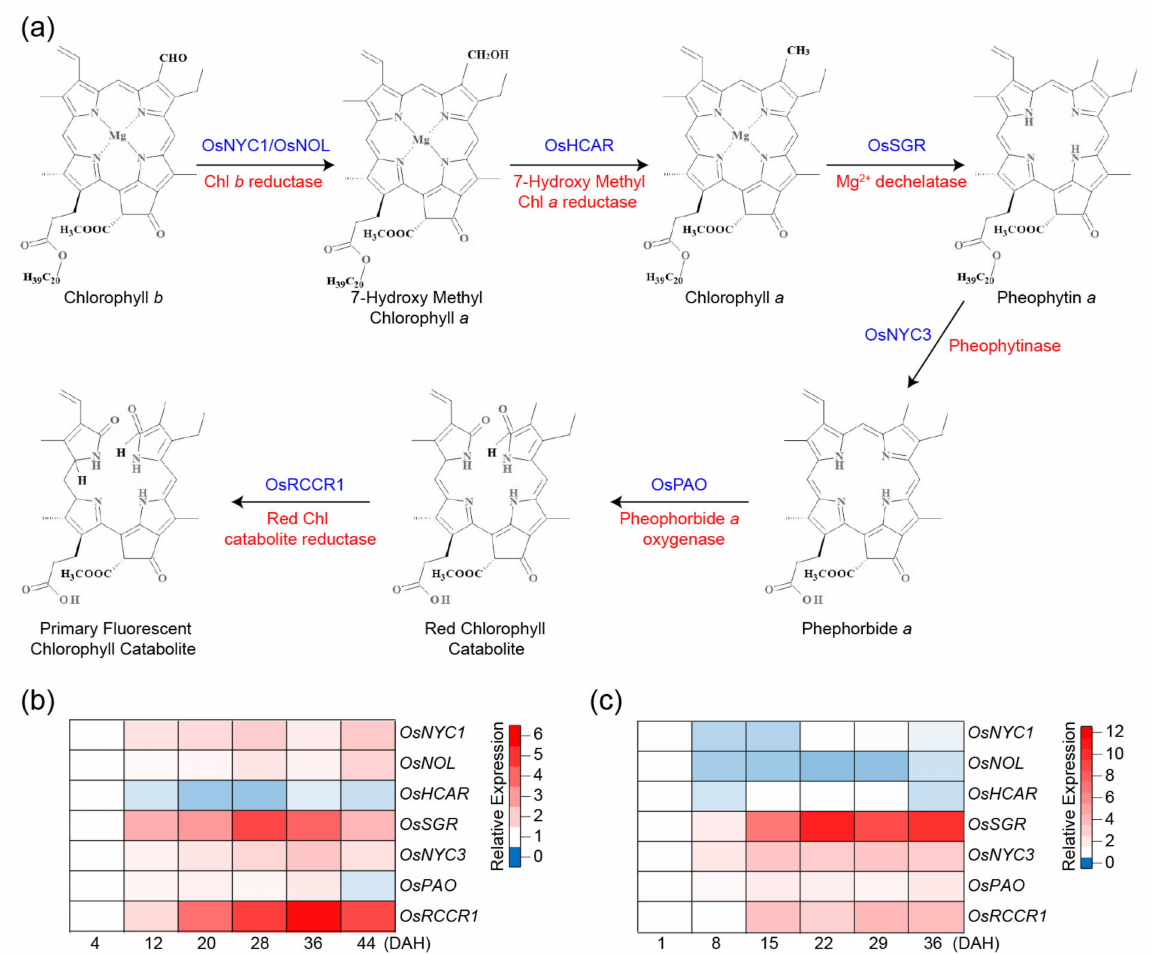
Figure 1. The PAO/phyllobilin pathway of chlorophyll (Chl) breakdown in leaves and in silico analysis of the expression of Chl catabolic enzymes ( CCEs ) in rice flag leaves during the grain-filling stage. ( a ) Enzymatic reactions of the first part of the Chl degradation pathway, from Chl b to primary fluorescent Chl catabolite ( p FCC), that take place inside the chloroplast. See the text for abbreviations of enzyme names. Expression data were obtained from RNA-seq analysis ( b ) [20] and public microarray data ( c ) [21]. DAH; days after heading. Each expression data is normalized to starting time points (( b ), 4 DAH; ( c ), 1 DAH, respectively). Based on the transcript levels of starting time points, the relative gene expression levels of other time points were quantified. The blue or red colors indicate the lower or higher transcript abundances than those of relevant control (white),